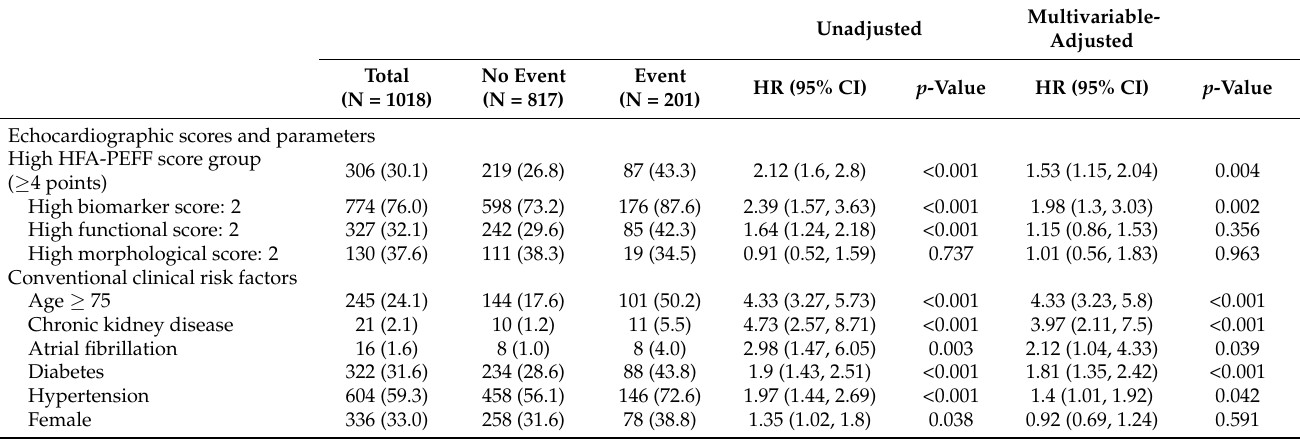
Table 3. Risk factors for all-cause death in patients with AMI and an HFA-PEFF score ≥